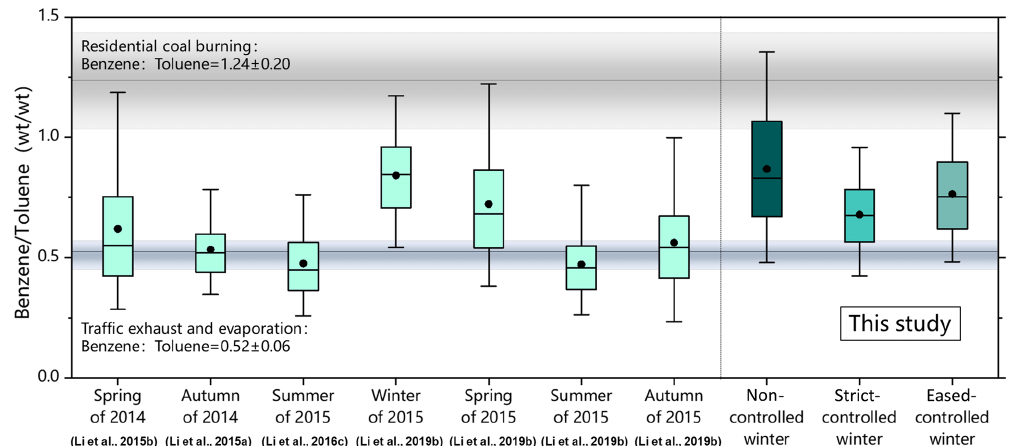
Figure 4. The ratios of benzene and toluene in different seasons (previous studies) and different control periods (this study). Table 1. The 20 VOC species which declined the most following emission controls during strict-control and eased-control periods. Species Non-control Strict-control Decreasing Species Non-control Eased-control Decreasing (ppbv) (ppbv) methacrolein